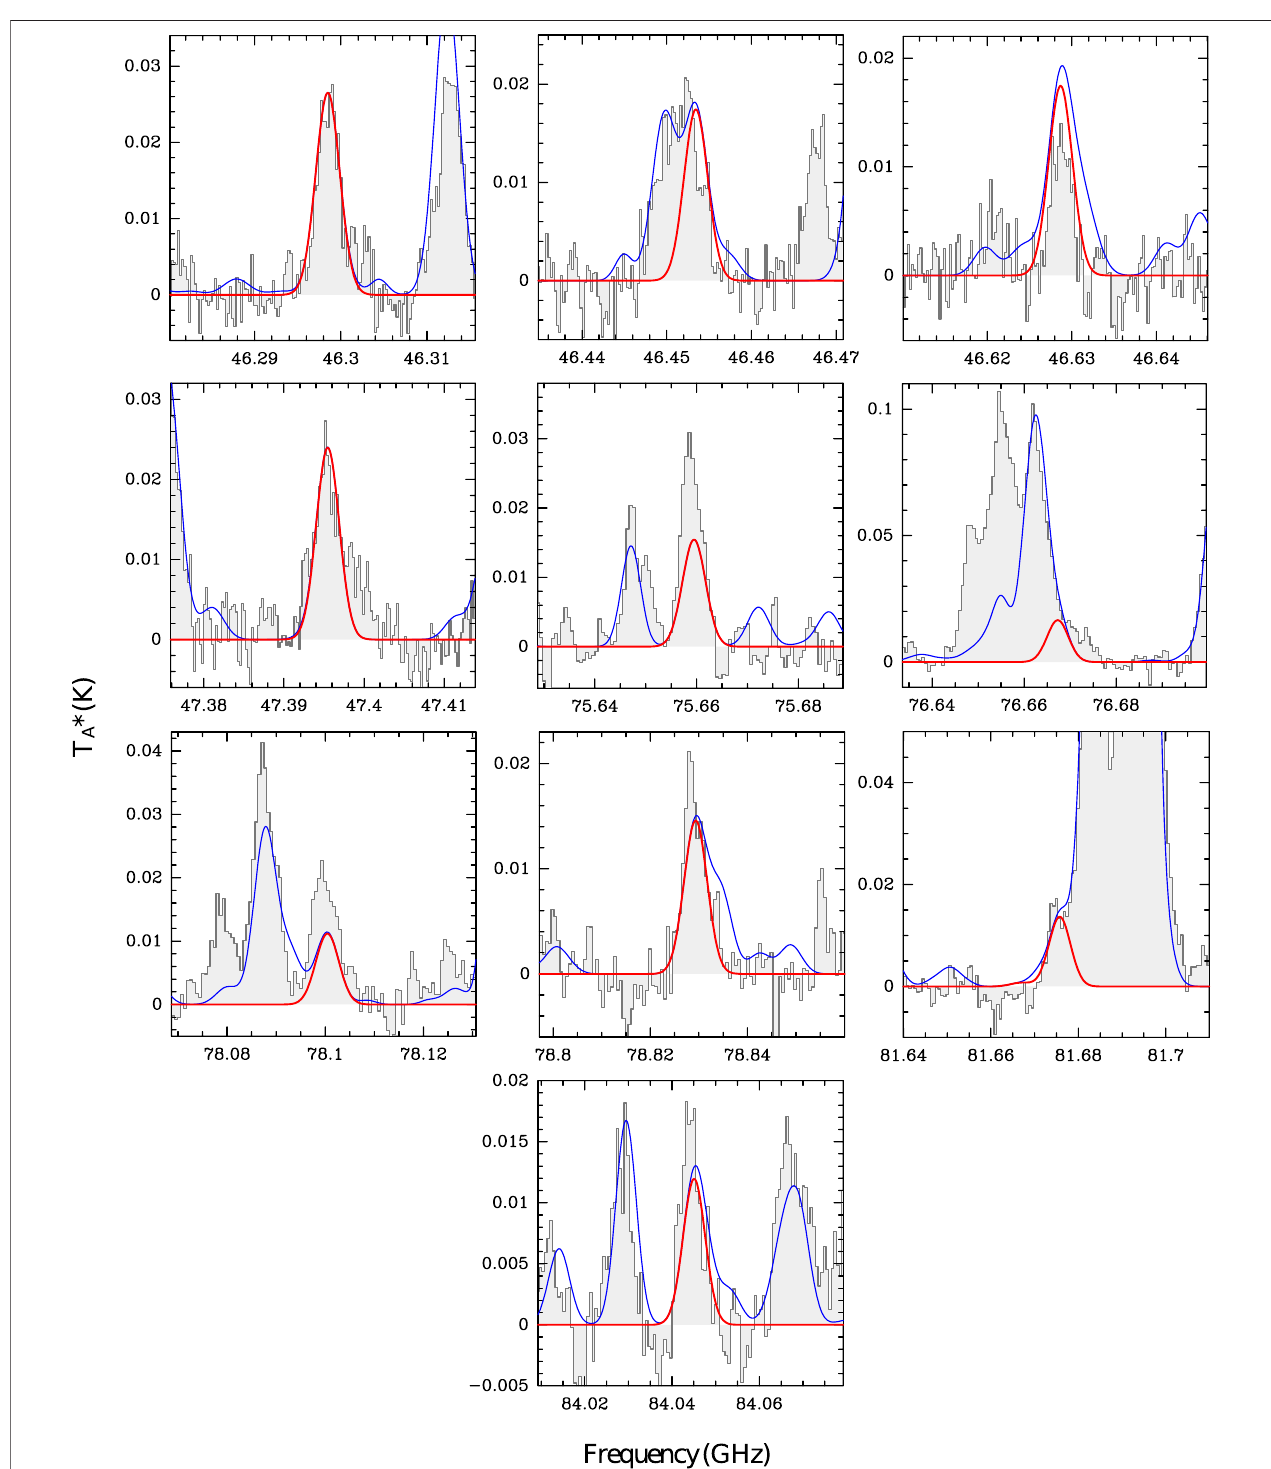
FIGURE 5 | Selected transitions of cyanoallene (CH 2 CCHCN; see Table 3 ) detected towards the G+0.693 molecular cloud. The best LTE fi t derived with MADCUBA for the CH 2 CCHCN emission is shown with a red curve, while the blue curve shows the total emission considering all the species identi fi ed towards this molecular cloud. The y-axis shows the line intensity in antenna temperature scale ( T A * ) in Kelvin, and the x-axis shows the frequency in GHz.